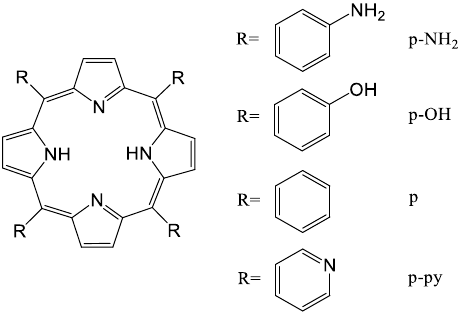
Figure 8. Chemical structures of porphyrins (p-NH 2 , p-OH, p, and p-py). In [133], photosensitive liposomes were prepared, based on three different phospho- lipids (1-stearoyl-2-oleoyl-sn-glycero-3-phosphocholine (SOPC), 1,2-dioleoylsn-glycero- 3-phosphocholine (DOPC) or 1-stearoyl-2-linoleoyl-sn-glycero-3-phosphocholine (SLPC))